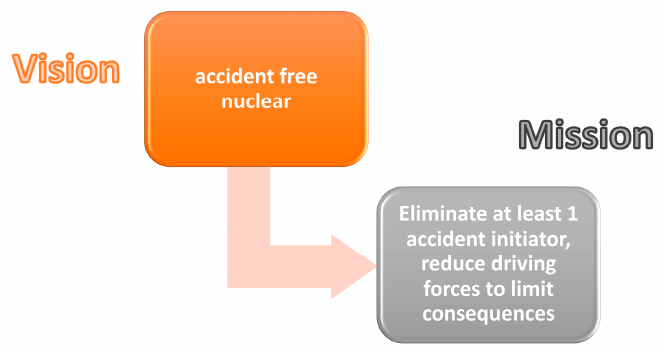
Figure 9. Translating the vision of accident-free nuclear into a viable mission.